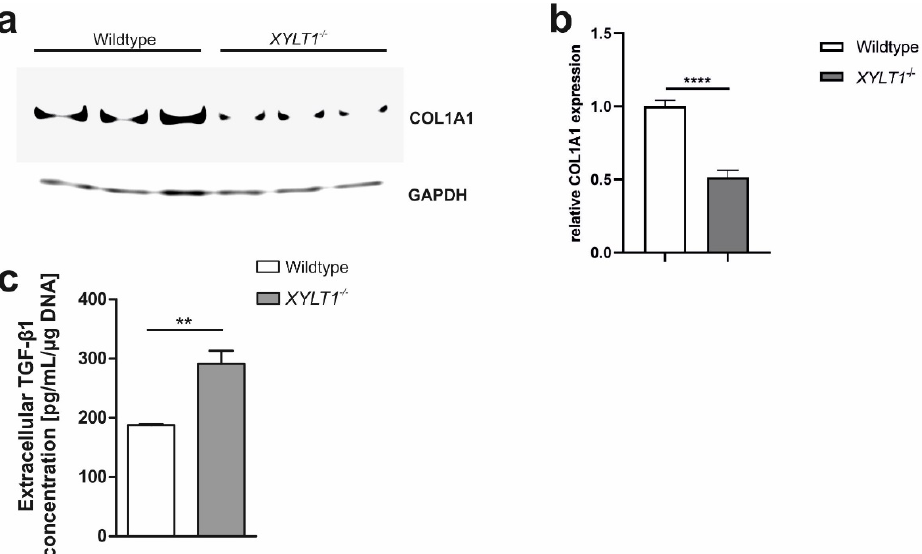
Figure 5. COL1A1- and TGF- β 1 protein expression. For COL1A1 Western blot analysis, cells were cultivated for a total of 72 h in standard-cell culture medium, containing 10% FCS. Cells were then